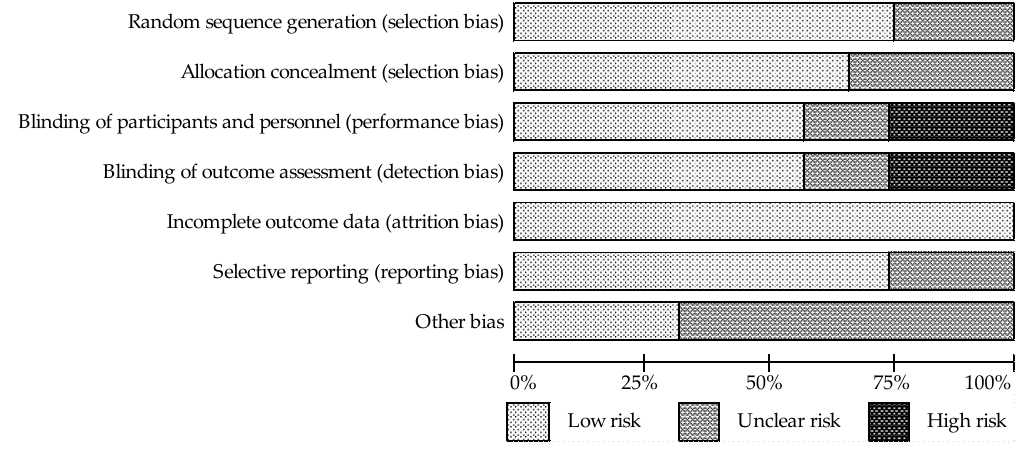
Figure 3. The assessment of risk of bias for each items; data are shown as percentage for studies.